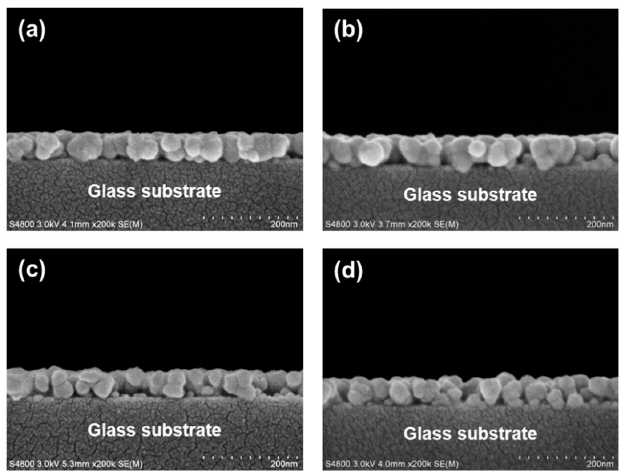
Figure 3. Cross-sectional field-emission scanning electron microscope (FE-SEM) micrographs